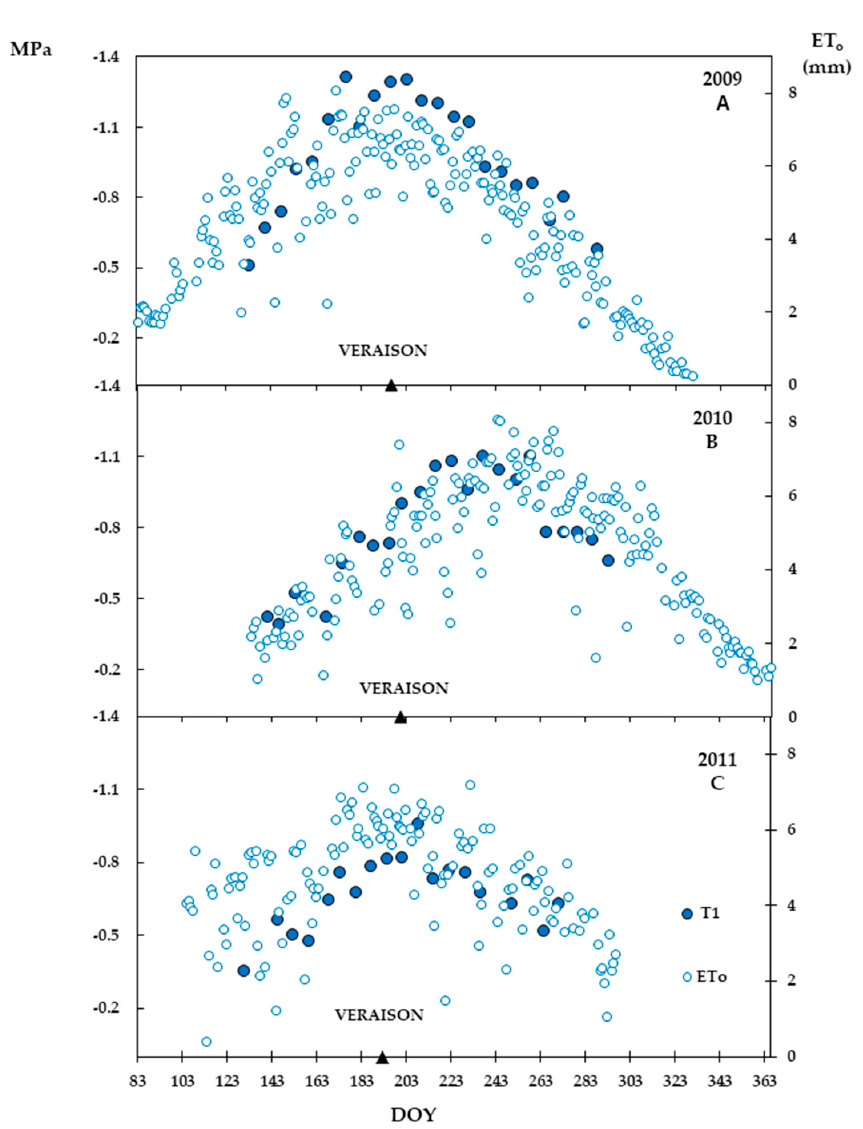
Figure 2. Seasonal evolution of stem water potential measured at midday ( ψ smd ) in rainfed treatment (T1) and ET o obtained with the weighing lysimeter in the years ( A ) 2009, ( B ) 2010, and ( C ) 2011. Each point of ψ tmd represents the average value of 4 high load subplots.